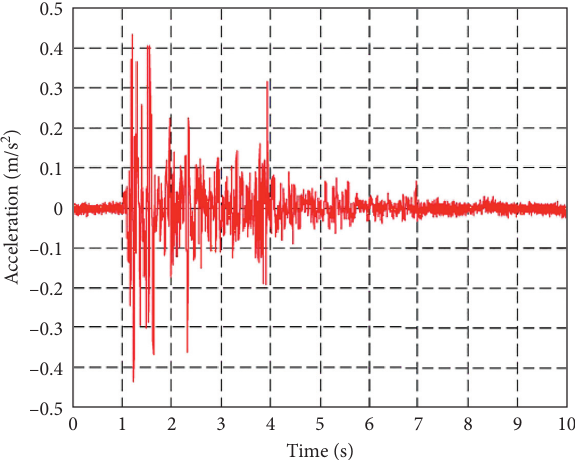
Figure 4: The signal wave of the measuring